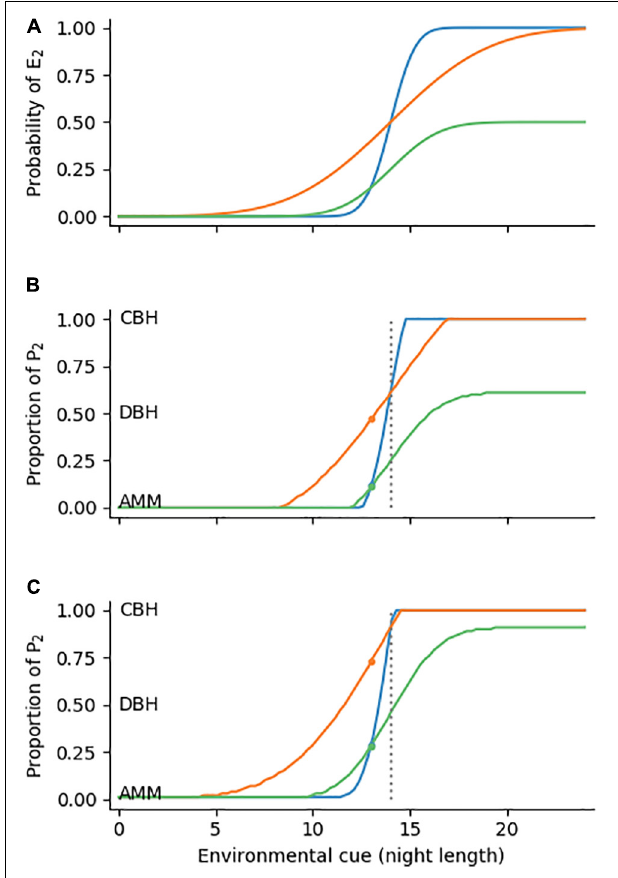
FIGURE 2 | Panel (A) Probability of encountering environment E 2 (winter conditions) for different values of an environmental cue c (e.g., night length). E 2 fluctuates around c according to three normal distributions N 1 (14,1), N 2 (14,4), and 0.5 * N 3 (14,2) (blue, orange, green). Shown are cumulative probability functions of the three distributions. (B) Optimal reaction norm shapes (e.g., proportion p of diapausing offspring for different night lengths) under the three scenarios of environmental uncertainty introduced in panel (A) . As in the main text, fitness of P 1 (parthenogenesis) is 4 in E 1 and 0.1 in E 2 , whereas fitness of P 2 is always 1. (C) optimal reaction norm shapes when fitness of P 1 is 4/0 and fitness of P 2 is 1.8/1.8 in E 1 / E 2 , respectively. Dotted lines represent c = 14 h, small colored dots refer to the examples given in the main